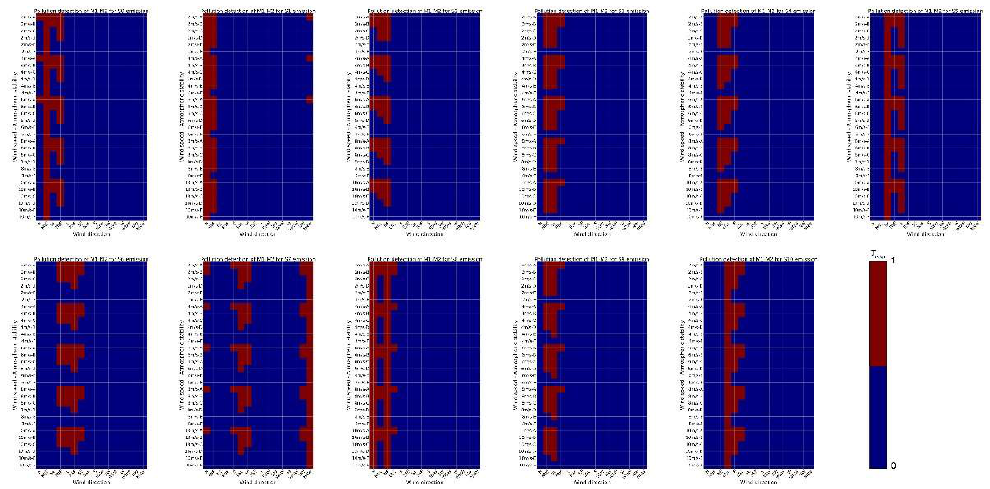
Figure A1. T m,e,i of integrated M 1 and M 2 for different source emissions under different meteorological conditions.